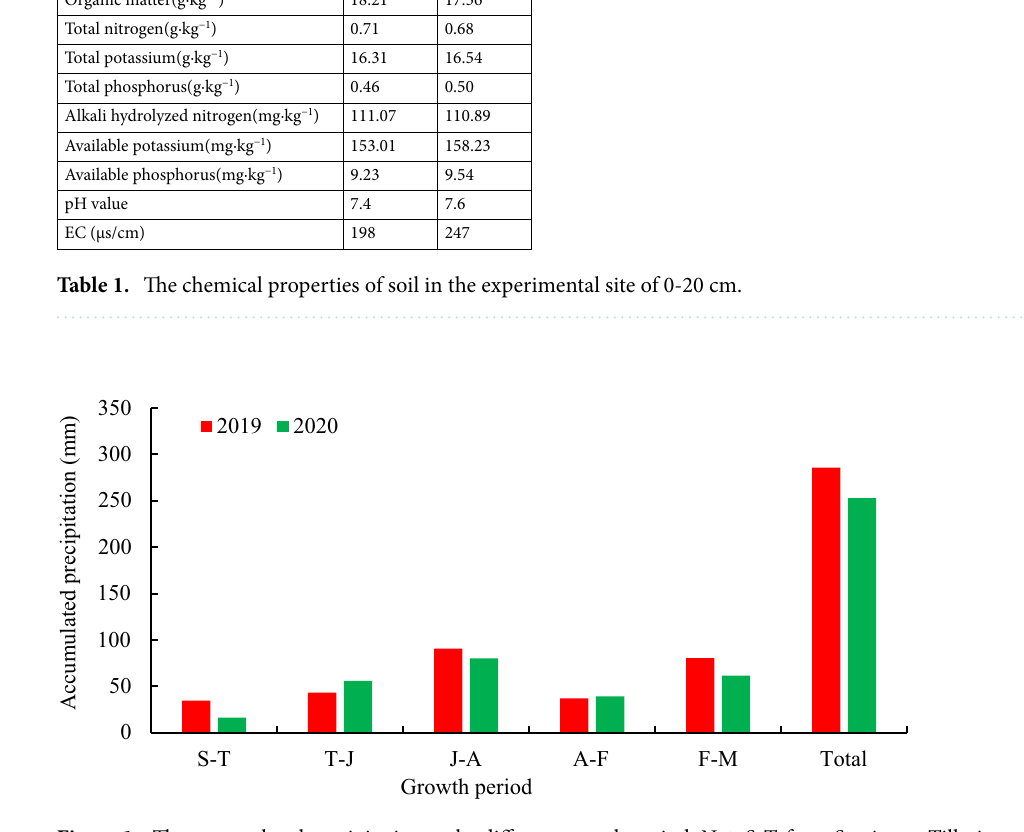
Figure 1. The accumulated precipitation at the different growth period. Note S-T, from Sowing to Tillering; T-J, from Tillering to Jointing; J-A, from Jointing to Anthesis; A-F, from Anthesis to Filling; F-M, from Filling to